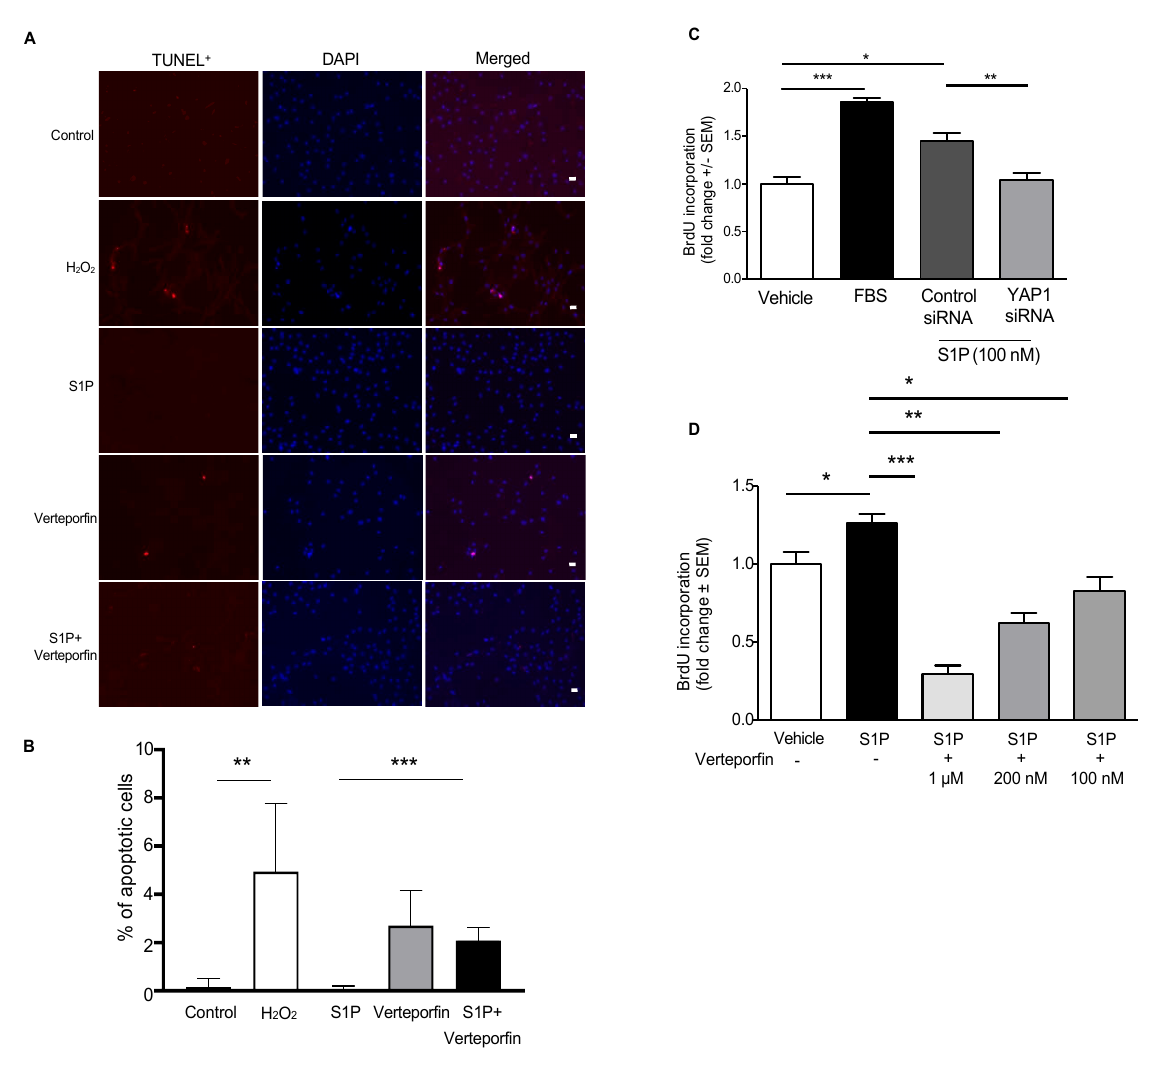
Figure 9. YAP1 regulates S1P-mediated proliferation in hPASMCs. ( A ) Representative images and ( B ) quantitative data from TUNEL assays. hPASMCs were cultured on a coverslip in a six-well cell culture plate. H 2 O 2 (100 µM) was used as an apoptosis stimulus for hPASMCs. When cell confluence reached ~95%, cells were starved for 3 h, pre-treated with verteporfin (200 nM, 1 h)) and challenged with H 2 O 2 or S1P (1 µM) for 24 h. Cell apoptosis was examined using an in situ BrdU–Red DNA fragmentation (TUNEL) kit. Representative images from each group are demonstrated. Scalebar: 20 µm. ** p < 0.01; *** p < 0.001. hPASMC cell proliferation was examined with BrdU assays; FBS (10%) was used as a positive control. ( C ) Silencing YAP1 with YAP1 siRNA (50 nM, 72 h) attenuated S1P- mediated hPASMC proliferation. ( D ) YAP1 inhibition with verteporfin (200 nM) attenuated S1P- mediated hPASMC proliferation in a dose-dependent manner. * p < 0.05; ** p < 0.01; *** p < 0.001. n = 3. Scale bar: 50 μ m